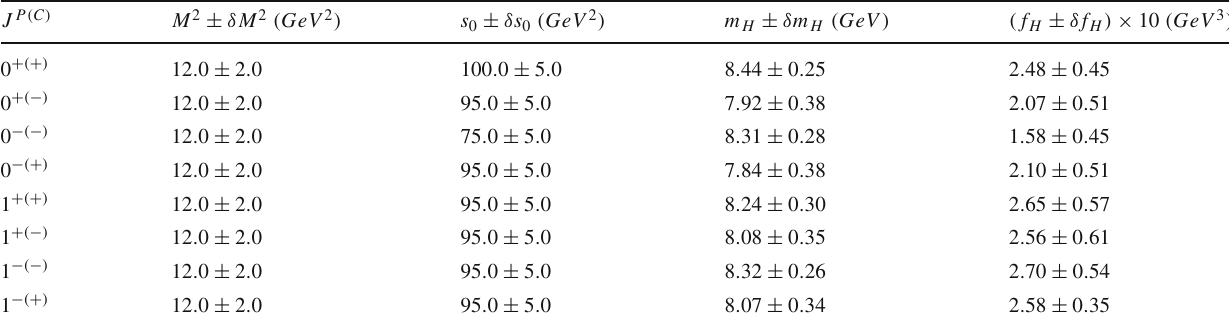
Table 7 Values of the mass and current coupling for different quantum numbers of the ground state bottom-nonstrange hybrid mesons J P ( C ) M 2 ± δ M 2 ( GeV 2 )